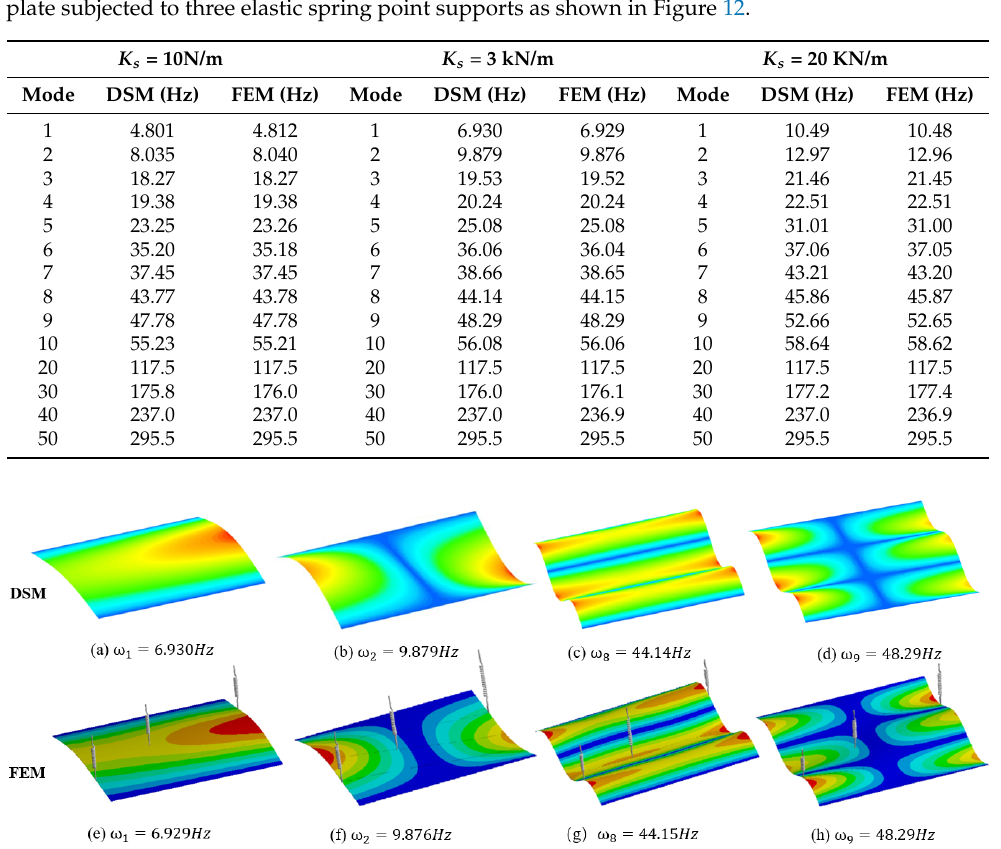
Figure 14. Comparison of the 1st, 2nd, 8th and 9th natural mode shapes of a plate subjected to three spring point supports with stiffness K s = 3 kN/m computed by both DSM and FE package ANSYS. As can be seen in Table 2, the DSM results are in good agreement with the FE